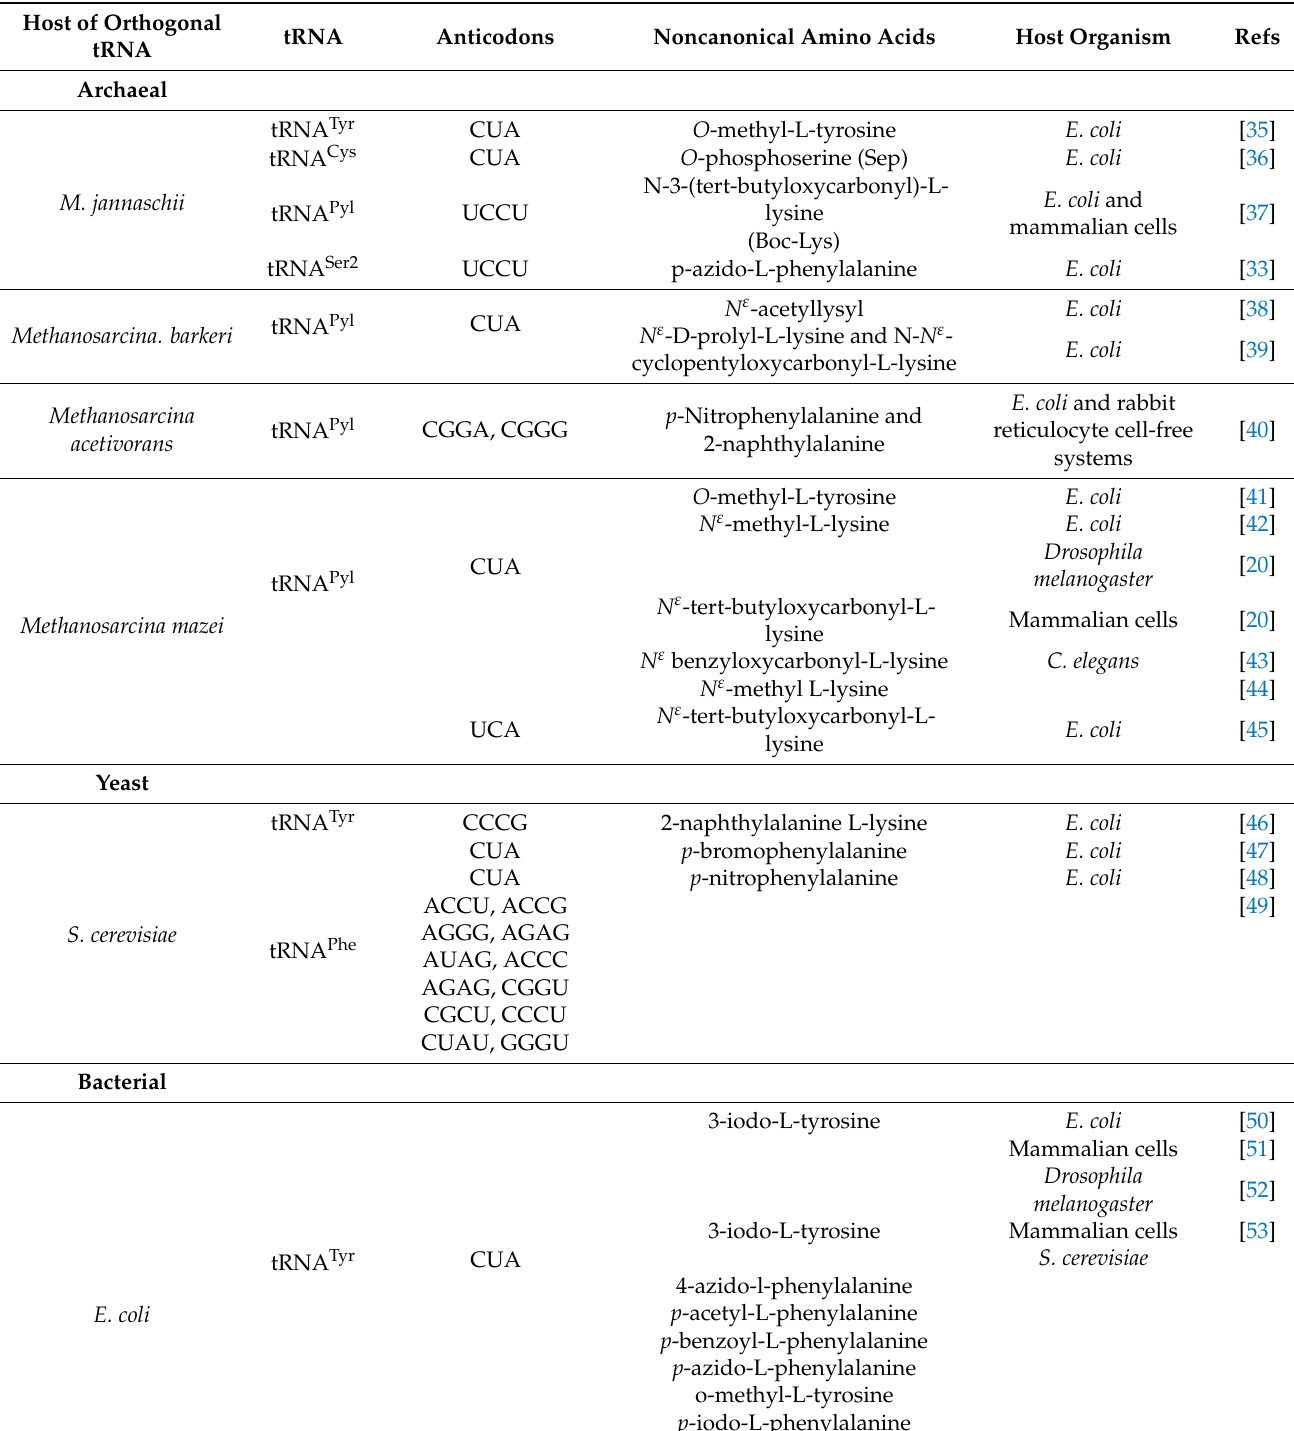
Table 1. Orthogonal tRNAs derived from different species discussed in the review and their hosts of